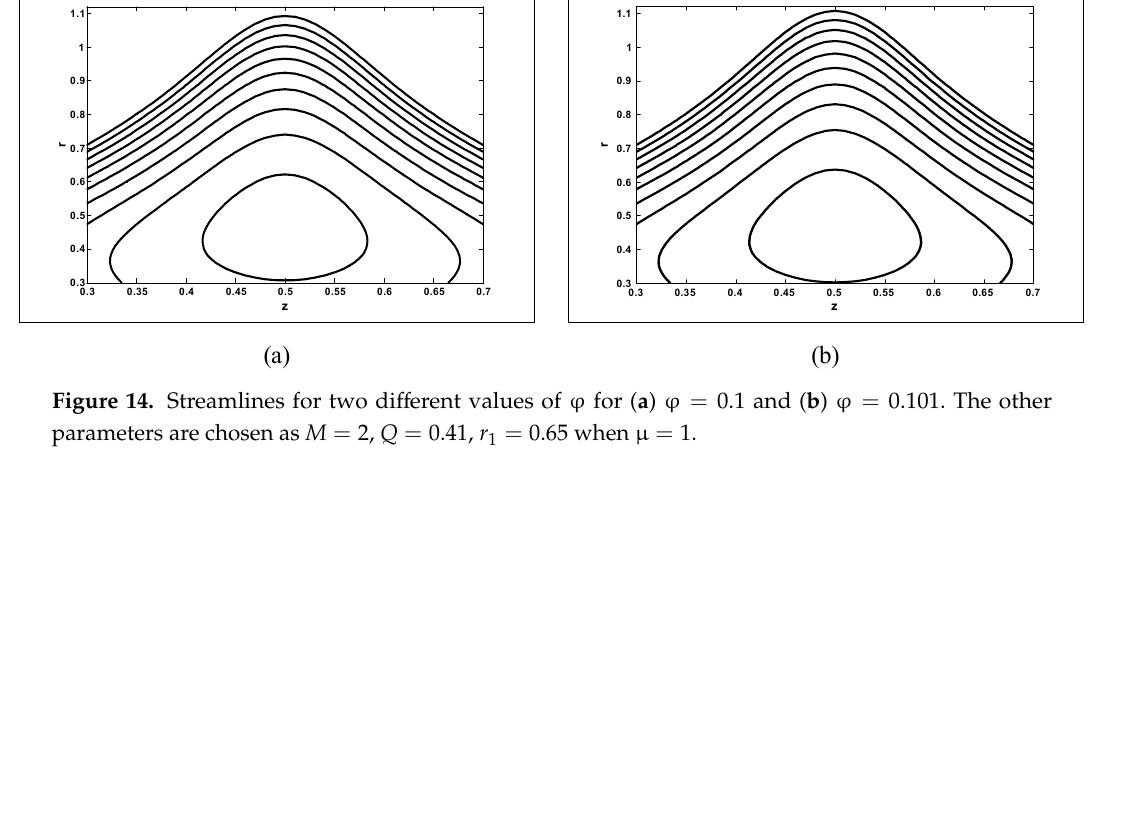
= M = M and ( b ) .6.0 The other = = r when μ . r 1